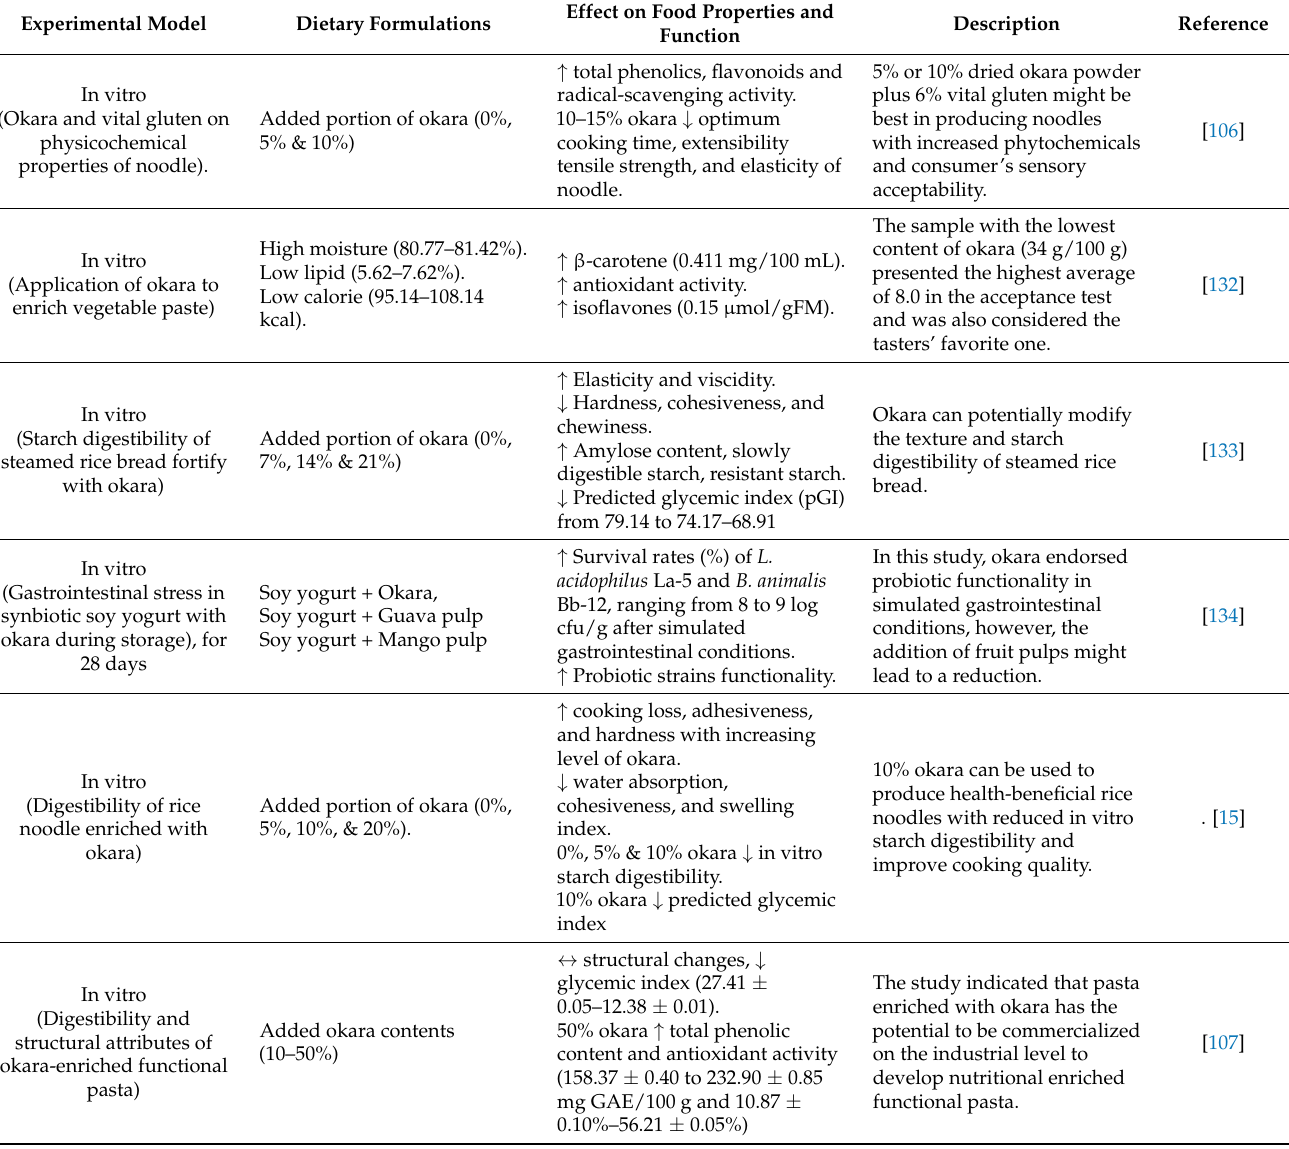
Table 4. Impact of okara fortification on food properties and